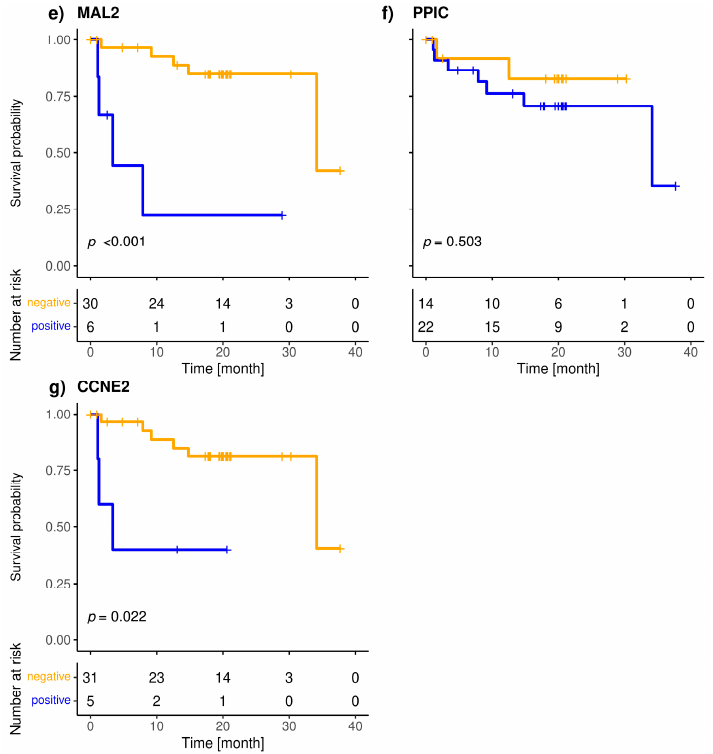
Figure 4. Kaplan-Meier plots of overall survival of Panel 2 ( a ), EMP2 ( b ), SLC6A8 ( c ), HJURP ( d ), MAL2 ( e ), PPIC ( f ) and CCNE2 ( g ) positive (blue), and negative (orange) metastatic breast cancer patients; Bonferroni corrected p -values are shown, p < 0.05 is defined as significant.